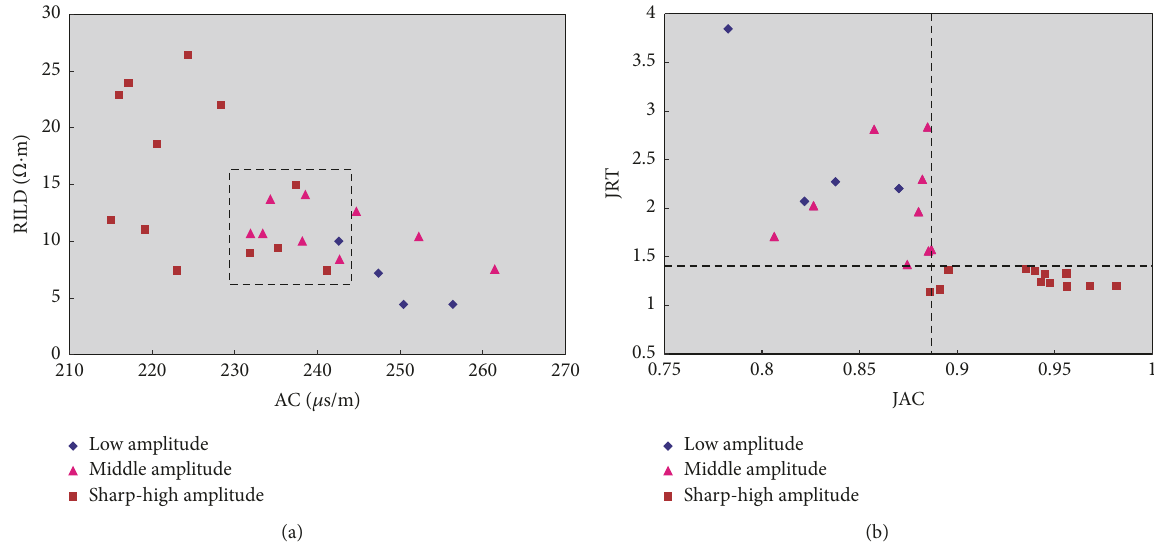
Figure 8: Standard identification of calcareous interlayers (sharp-high amplitude logfacies). (a) Cross plot of the parameters RILD and AC is invalid to identify low amplitude, middle amplitude, and sharp-high amplitude logfacies. (b) Cross plot of the parameters JRT and JAC is effective to identify sharp-high amplitude type from those three logfacies. Table 2: Production distribution of part of wells in the area of the